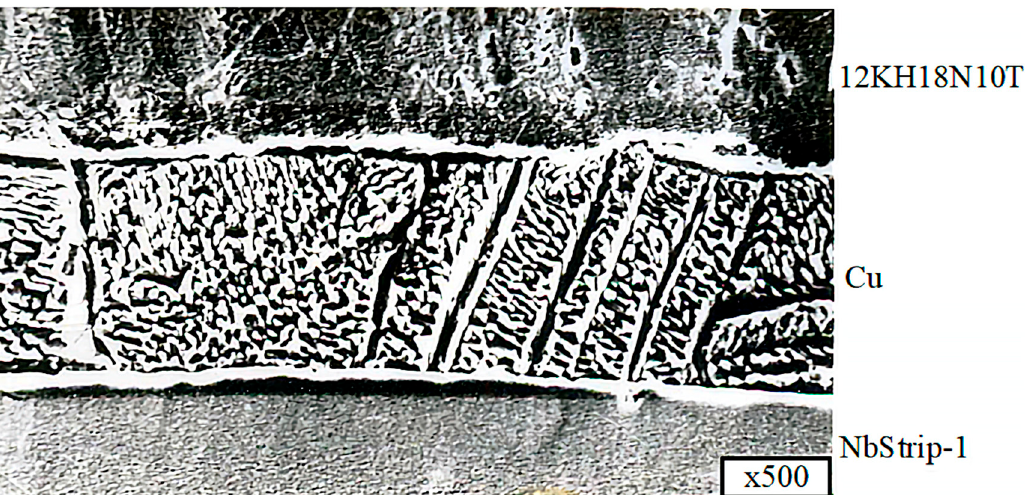
Figure 20. 12KH18N10T+NbStrip-1 (in secondary electrons) connection.